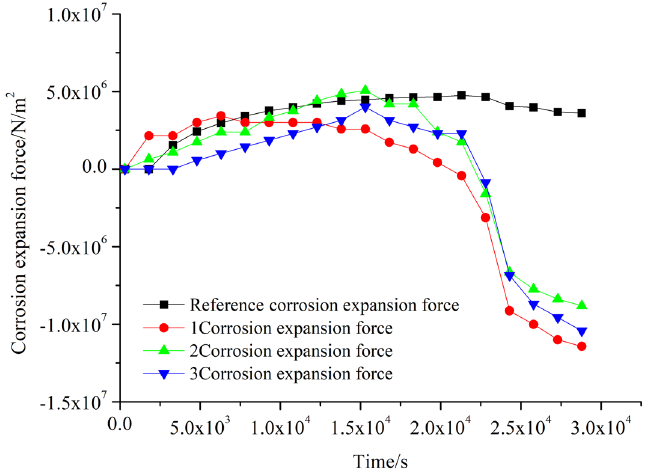
Figure 13. Comparison between referential corrosion expansion force and corrosion expansion force at different